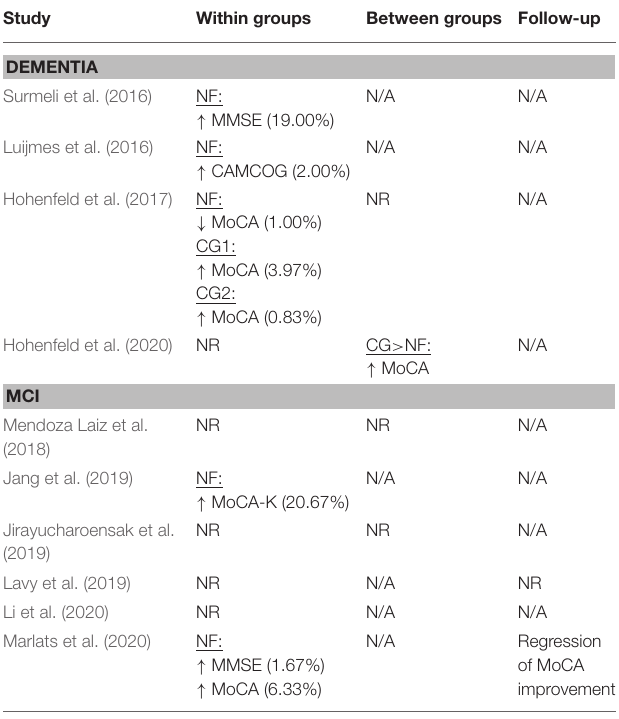
TABLE 5 | Summary of outcomes from standardized cognitive assessment scales.